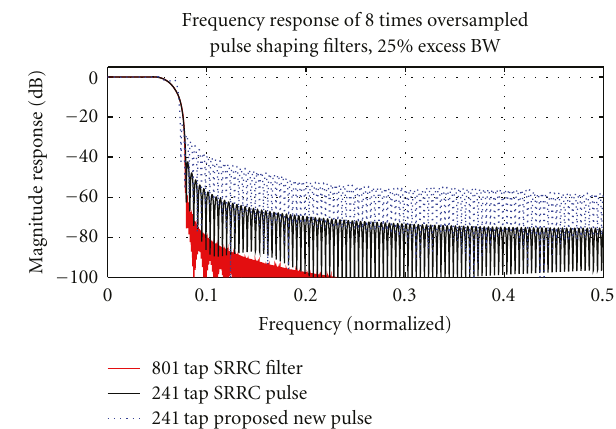
Figure 8: Frequency response of proposed new pulse compared with SRRC Filter.